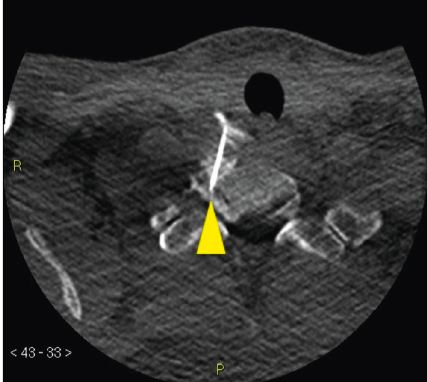
Figure 5: CT-guided injection. Axial section showing the tip of the 22G spinal needle at the right C7/T1 foramen. The contrast was injected to confirm flow centrally (yellow arrowhead).